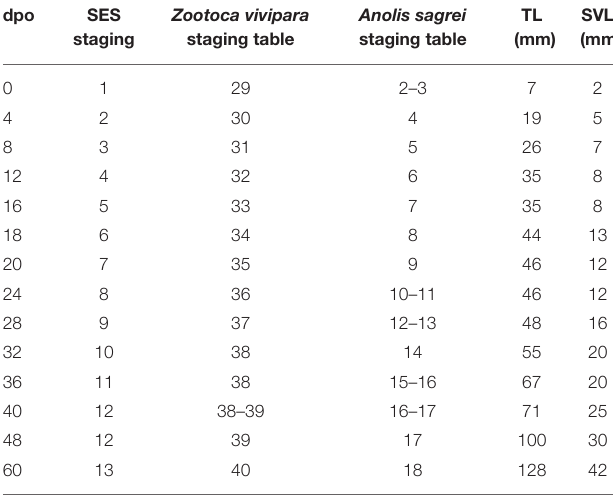
TABLE 3 | Embryonic staging in Pogona vitticeps